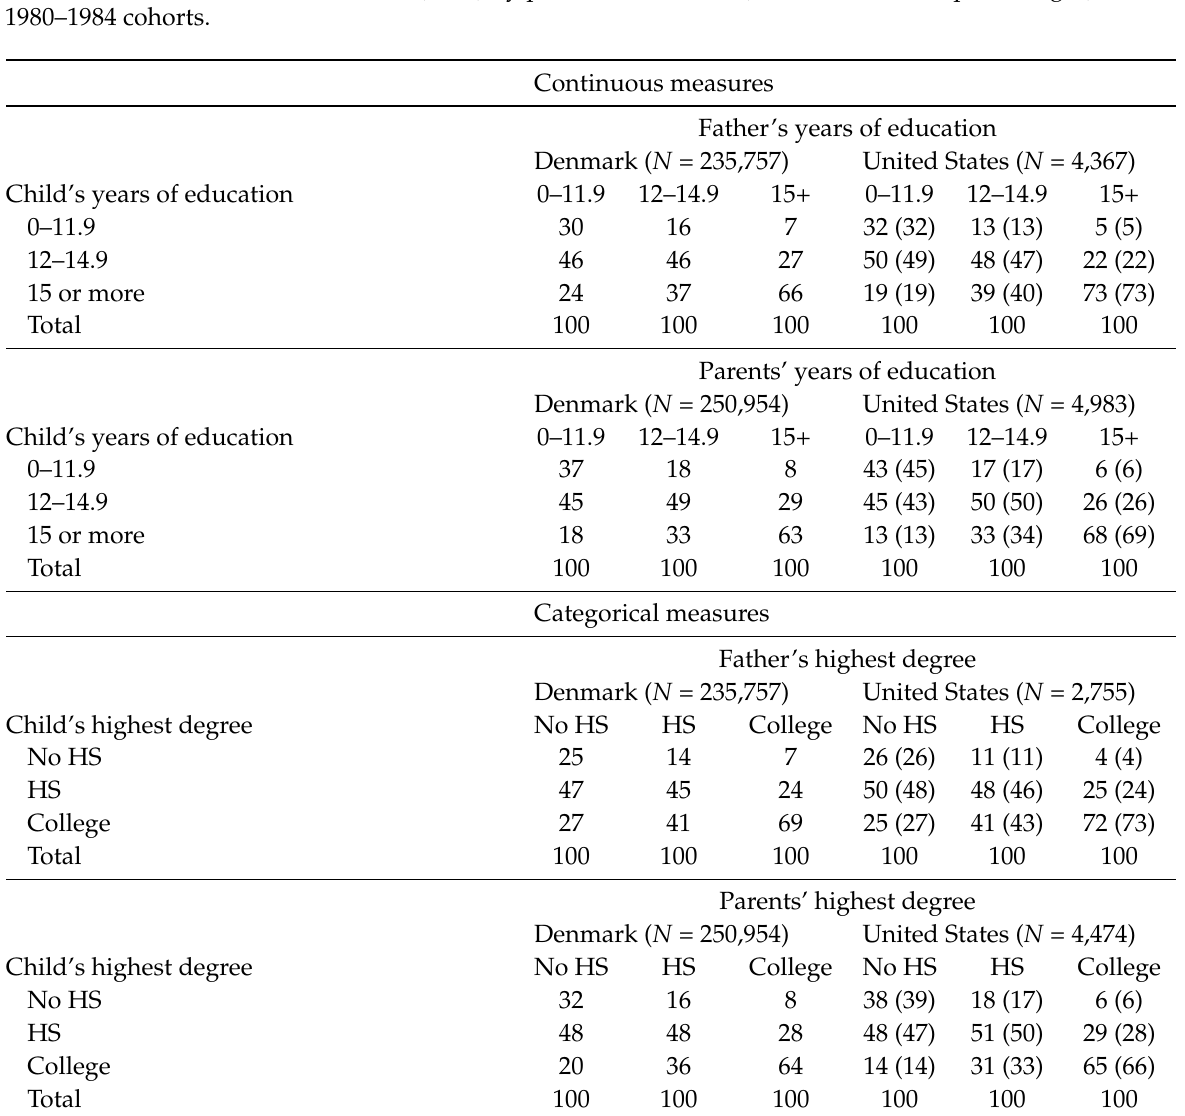
Table 2: Children’s educational status (2013) by parents’ education (shown as column percentages) for